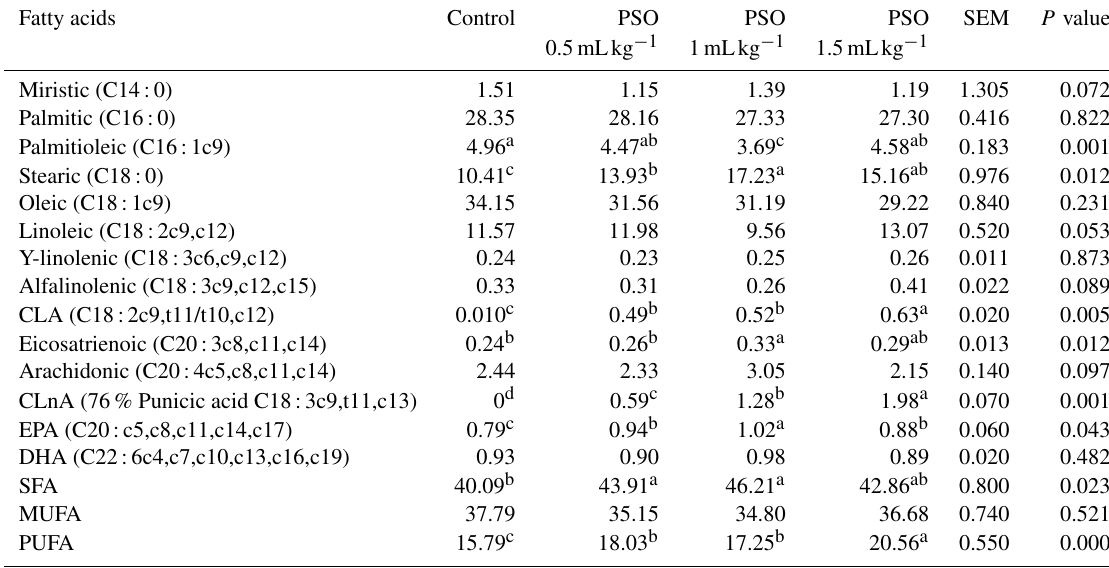
Table 7. Effects of PSO on the fatty acid composition in the yolk of laying hens. Fatty acids